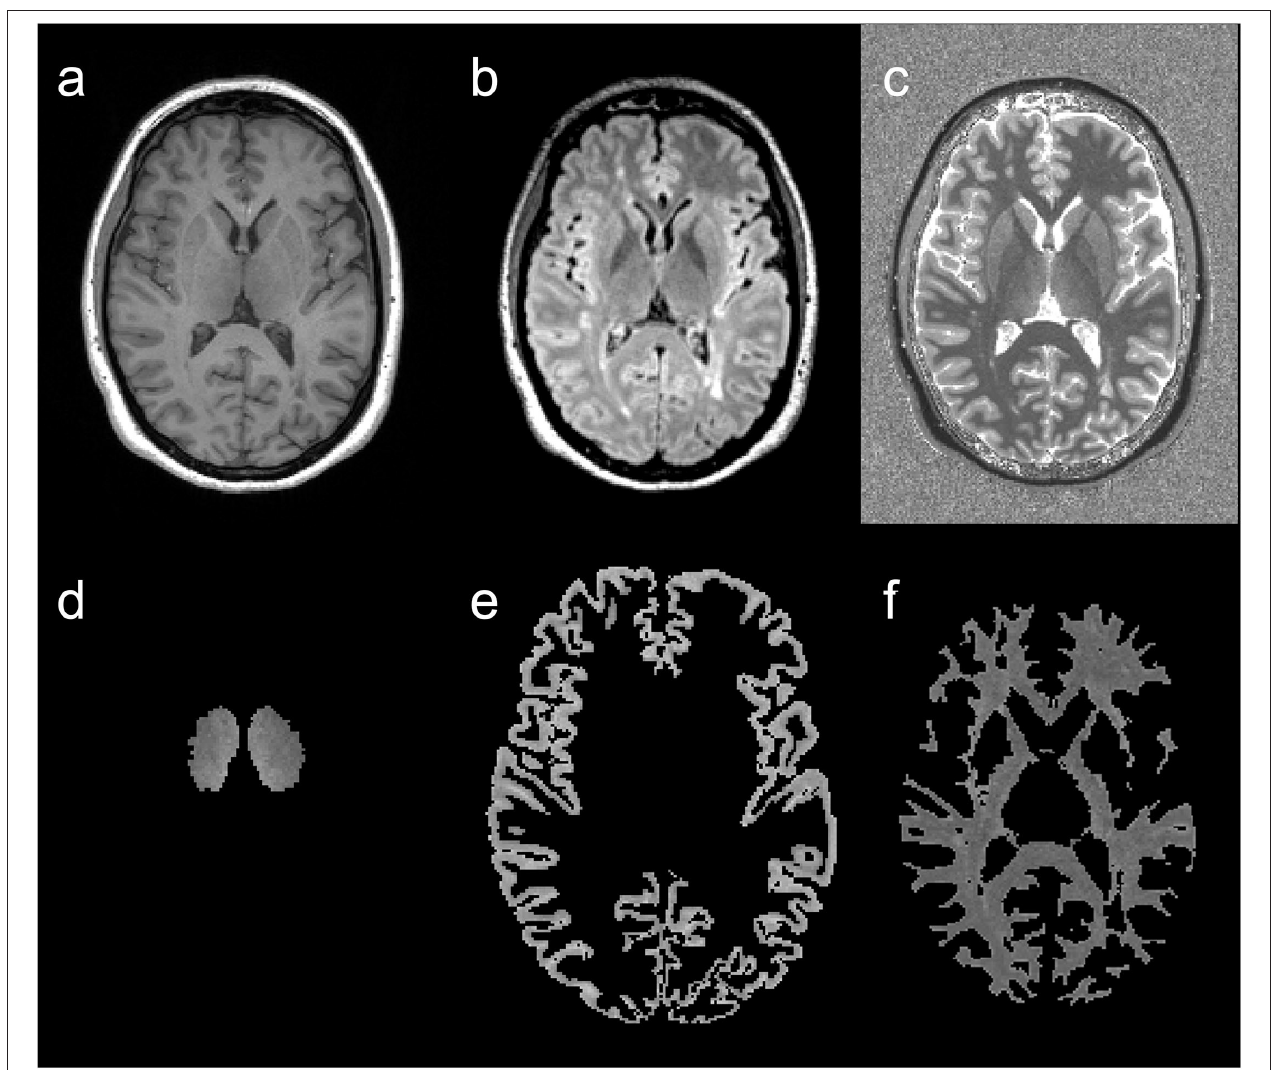
FIGURE 1 | Example of image segmentation. T1w magnetization-prepared rapid gradient echo (MP2RAGE) (a) , fluid attenuated inversion recovery (FLAIR) (b) , and MP2RAGE (c) images and corresponding segmentation results of an MS patient’s T1 relaxation times (T1-RT) map: thalamic T1-RT map (d) , cortical T1-RT map (e) and white matter T1-RT map (f) with removed lesions